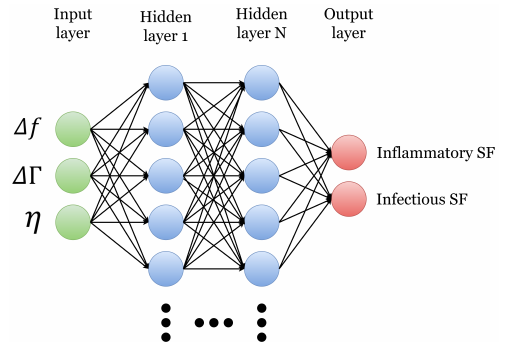
Figure 2. Artificial Neural Network model.